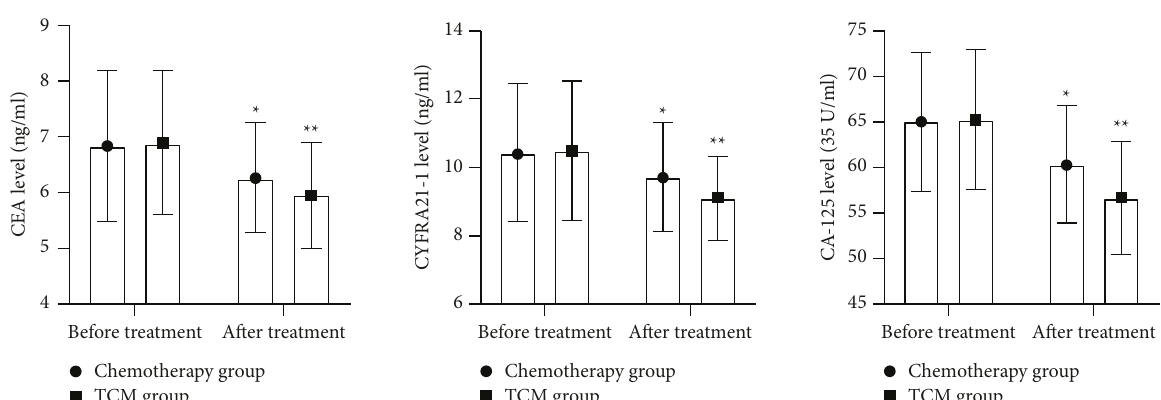
Figure 1: Comparison of serum tumour markers between the two groups. Note: compared with the chemotherapy group before treatment, ∗ P < 0 . 05; compared with the TCM group before treatment and the chemotherapy group after treatment, ∗∗ P < 0 . 05.